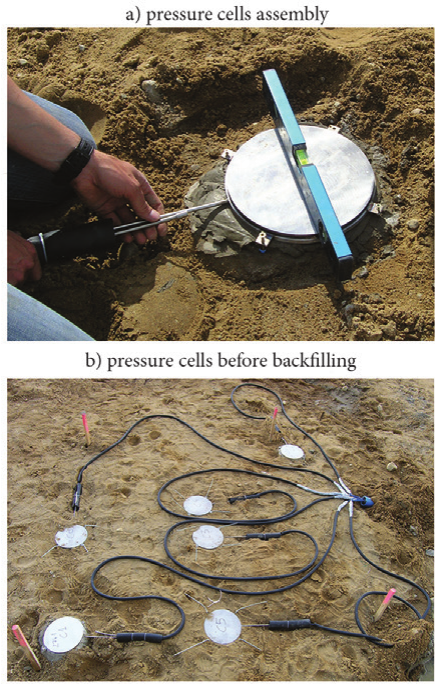
Fig. 4. Measurement points located on columns reinforcement Fig. 5. Vibrating wire load cells measurement